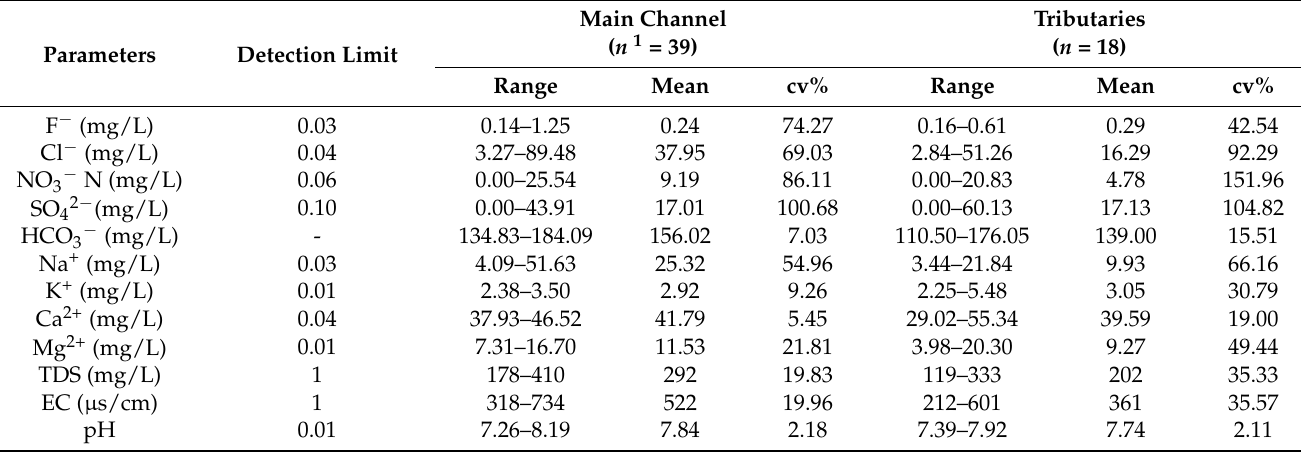
Table 1. Values of major elements and other hydrochemical parameters in the TGR.